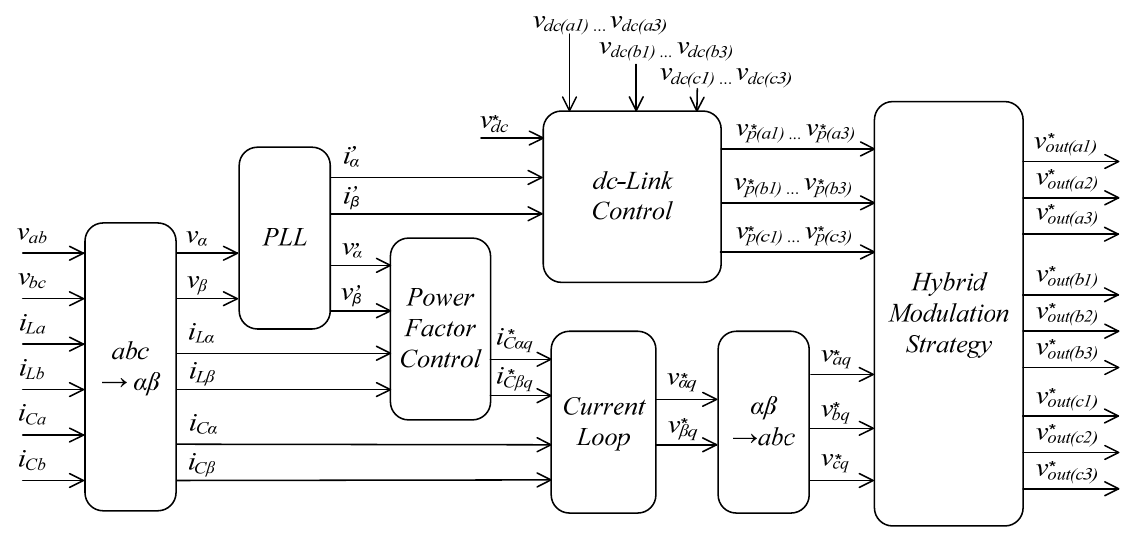
Figure 4. Power and control circuit diagram.